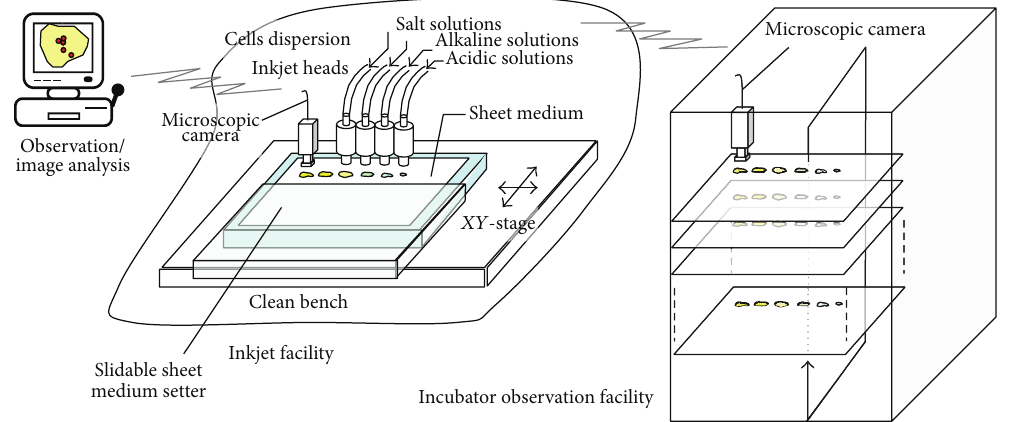
Figure 13: Bioassay system using inkjet printing and paper